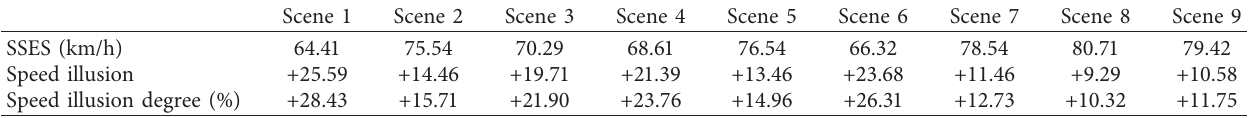
Table 6: Comparative analysis of subjective equivalent